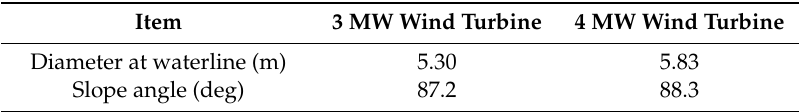
Figure 13. Sketch of the tested structures in full scale.